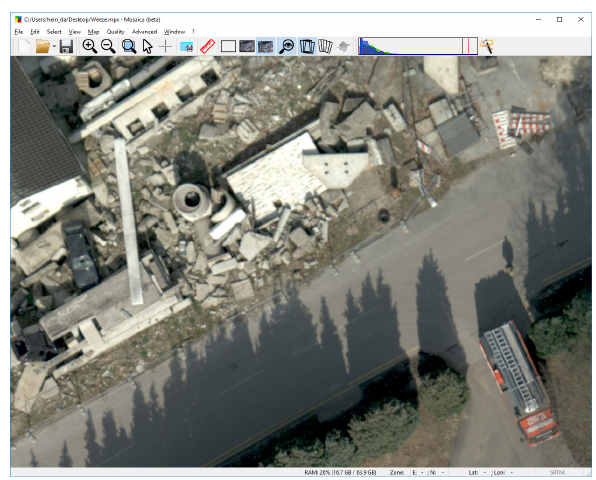
Figure 7. Detail view of quick-mosaic shown in figure 6 (yellow rect section) with a ground sampling distance of 3 . 5 cm per